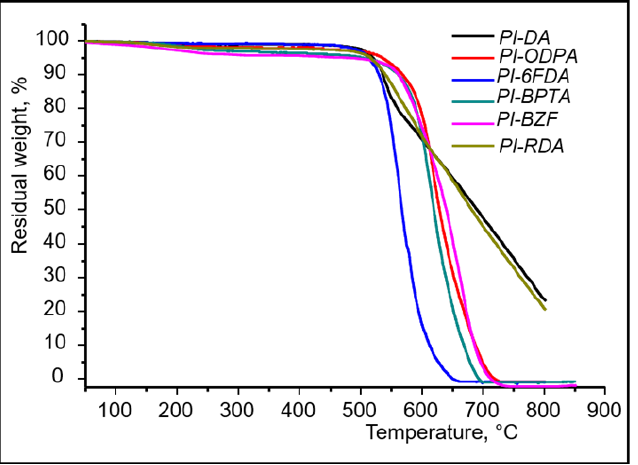
Table 3. DSC crystallization data for sample PI-BPDA.